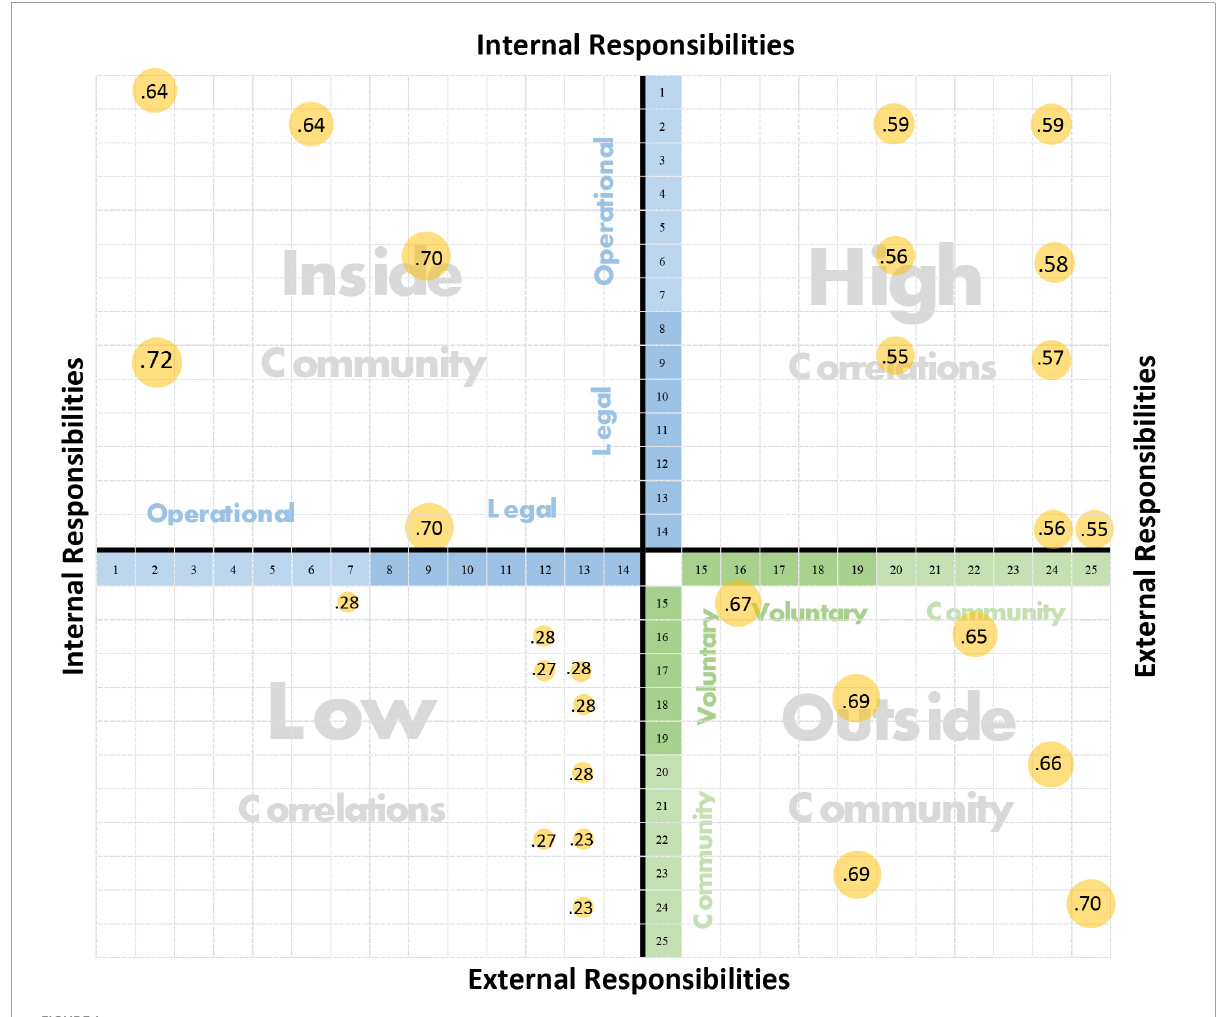
FIGURE1 I–O map of USRs with their correlation strength